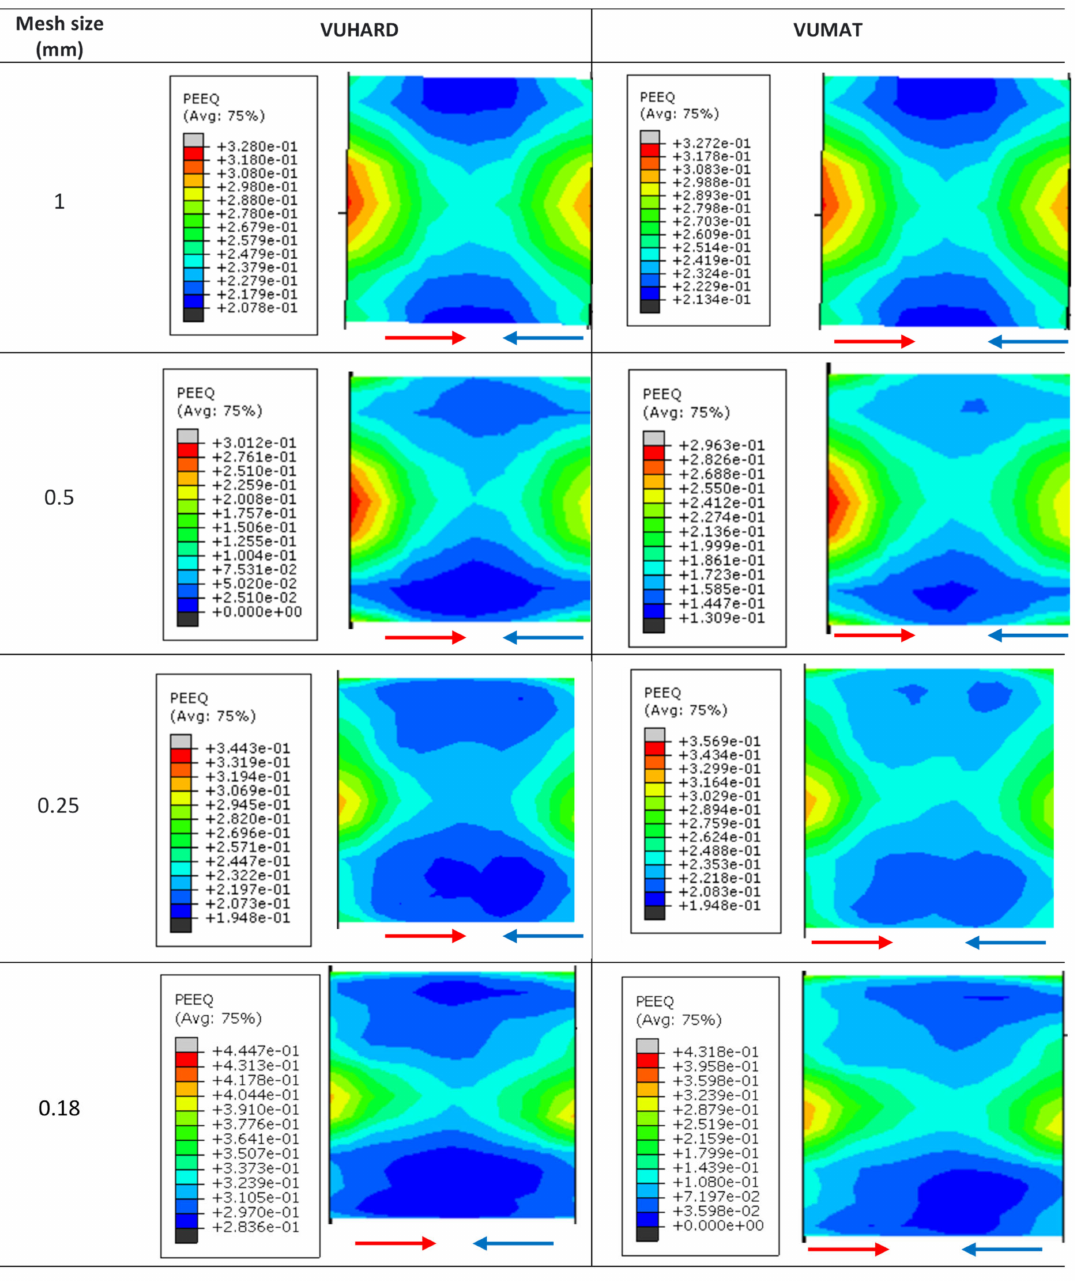
Figure 5. The equivalent plastic strain contours for a simulated SHPB test at a striker velocity of 8 m/s for 1 mm, 0.5 mm, 0.25 mm and 0.18 mm mesh sizes. (The red and blue arrows indicate the direction of incident and reflected waves,